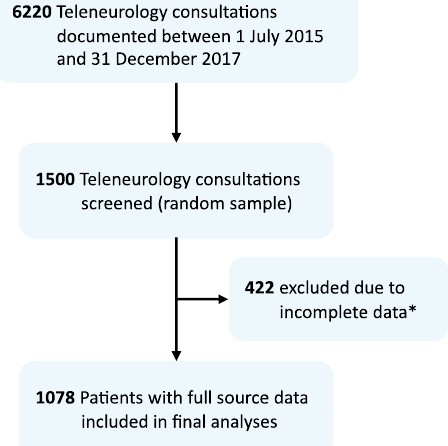
Figure 1. Flow chart of study population. * Of the 422 consultations excluded from analysis, n = 164 patients were excluded due to incomplete discharge data transfer to hub. In n = 228 patients, discharge data sets were incomplete or missing due to patient transfer to third-party CSC, discharge against medical advice, errors linking archived documents to teleneurological consultations, or changes in hospital information system documentation standards (1 center). Another n = 30 consultations were ultimately canceled or performed with no written standardized documentation.